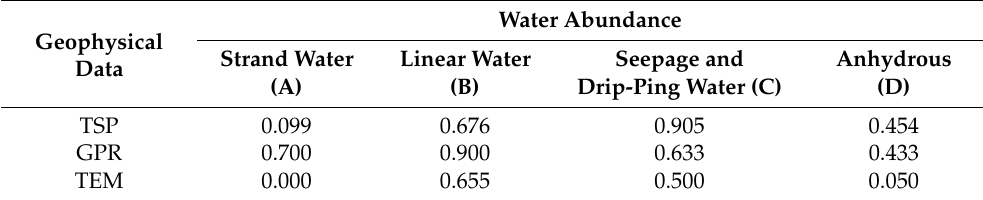
Table 5. Support degree of different geophysical data for water abundance.